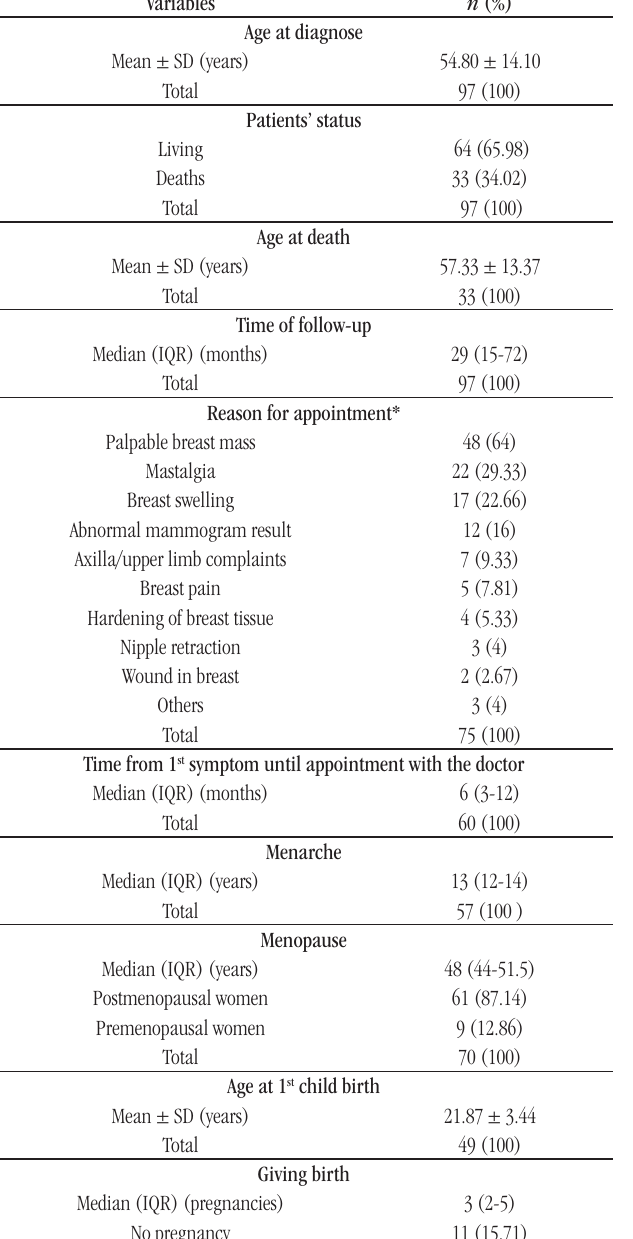
taBLE 1 − Clinical characteristics of the triple-negative breast cancer